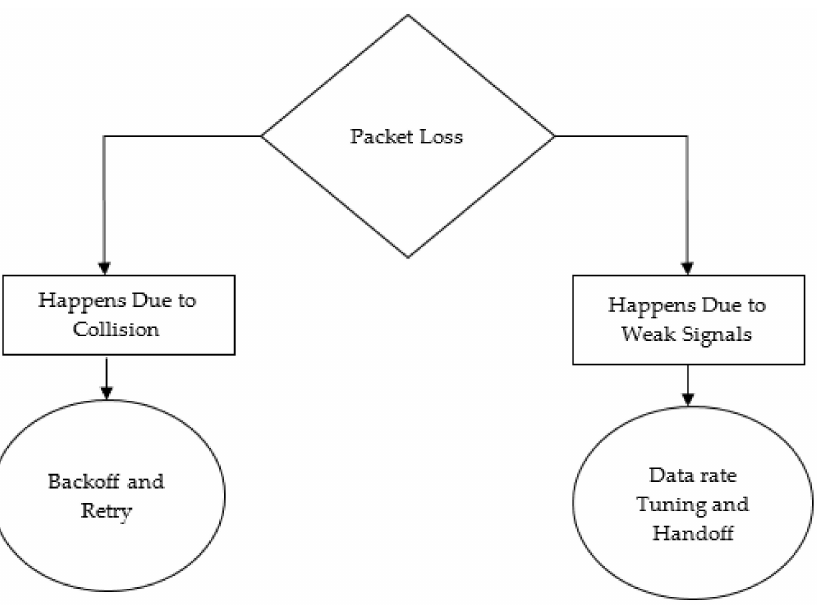
Figure 3. E1-carrier sense and weak channel